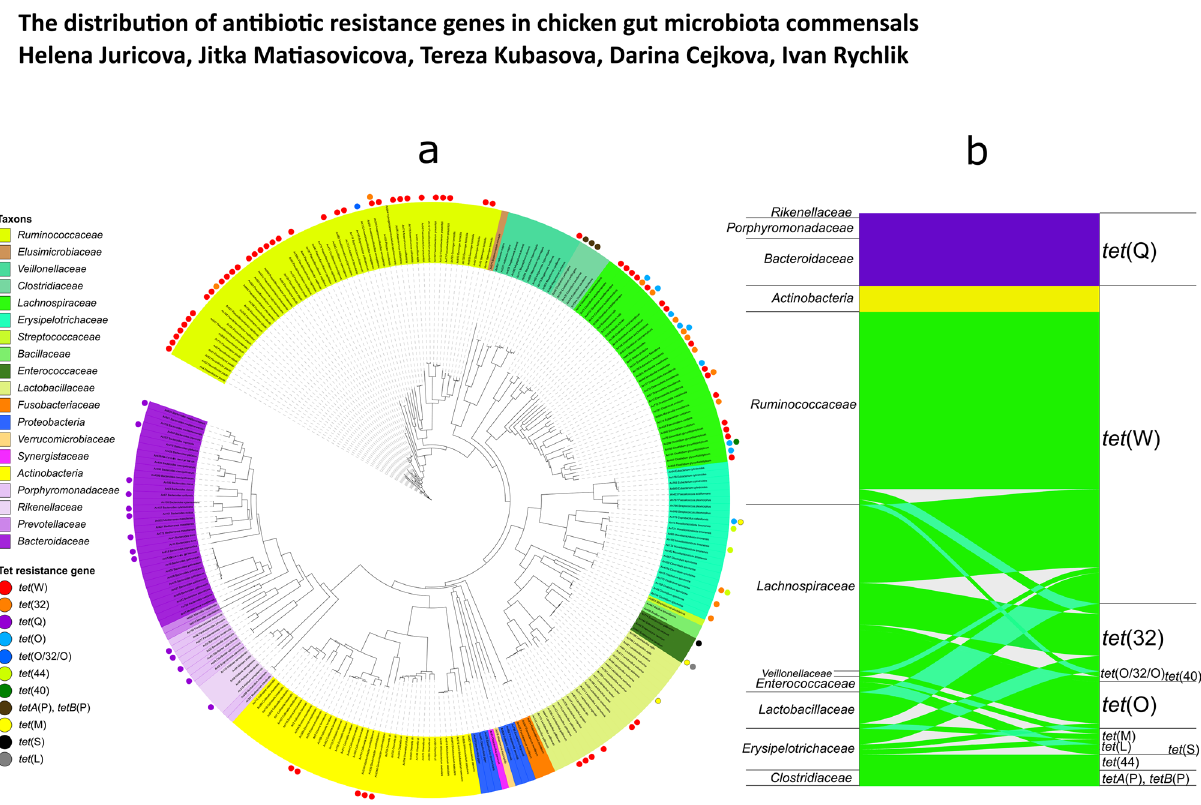
Figure 2. Presence of genes coding for resistance to tetracycline in isolates belonging to different phyla and families. ( a ) All isolates included in this study were aligned according to their 16S rRNA gene sequence. The phylogenetic tree was performed in iTOL v5.5.1, http://itol.embl.de 17 . The presence of particular tetracycline resistance genes is indicated by dots external to the dendrogram. ( b ) Distribution of tetracycline resistance genes among different families of chicken gut anaerobes. The alluvial diagram was produced in R v4.0.2, https :// www.R-proje ct.org/ 18